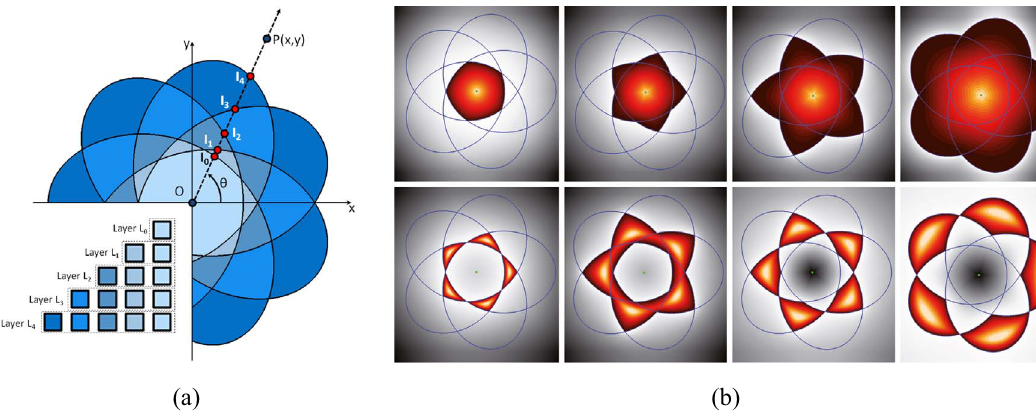
Figure 22. (a) Different layers in Rational Gielis curves. (b) RGC for p = 5 and q = 4 with different zones de fi ned